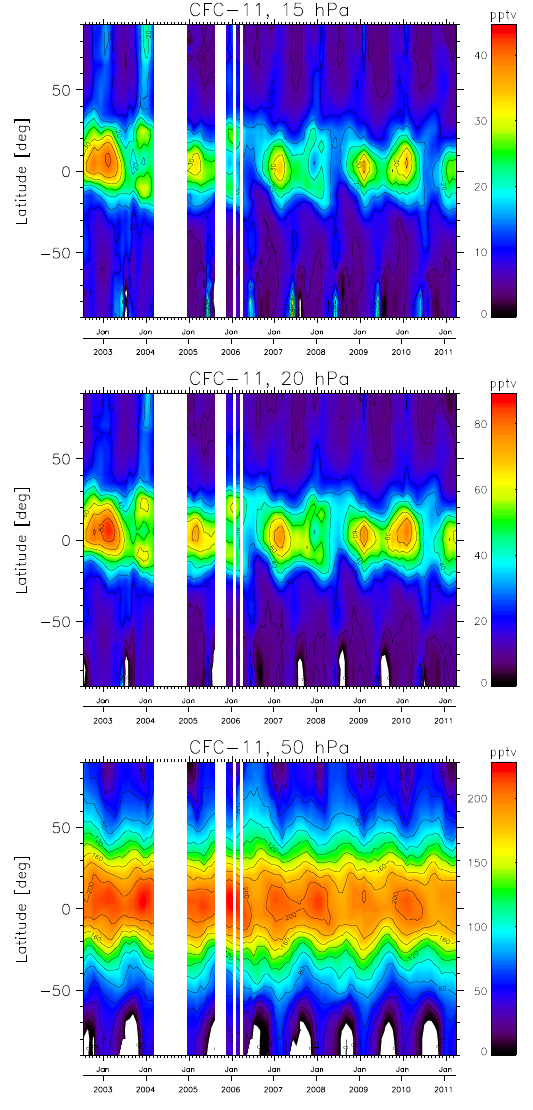
Fig. 6. Time series of CFC-11 as a function of latitude between Fig. 6. Timeseries of CFC-11as afunction of latitudebetween July July 2002 and April 2011 in 15hPa, 20hPa and 50hPa. Note there 2002 and April 2011 in 15 hPa, 20 hPa and 50 hPa. Note there is is no MIPAS data available between April and December 2004. The no MIPAS data available between April and December 2004. The white spots in the southern polar region indicate data gaps due to white spots in the southern polar region indicate data gaps due to the existence of not detected polar stratospheric clouds, because no the existence of not detected polar stratospheric clouds, because no retrievals are possible below cloud top altitude. retrievals are possible below cloud top